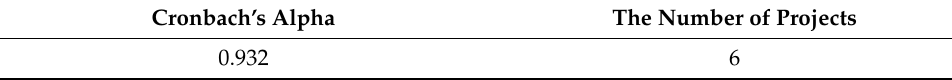
Table 4. Reliability statistics (exported from SPSS 22).